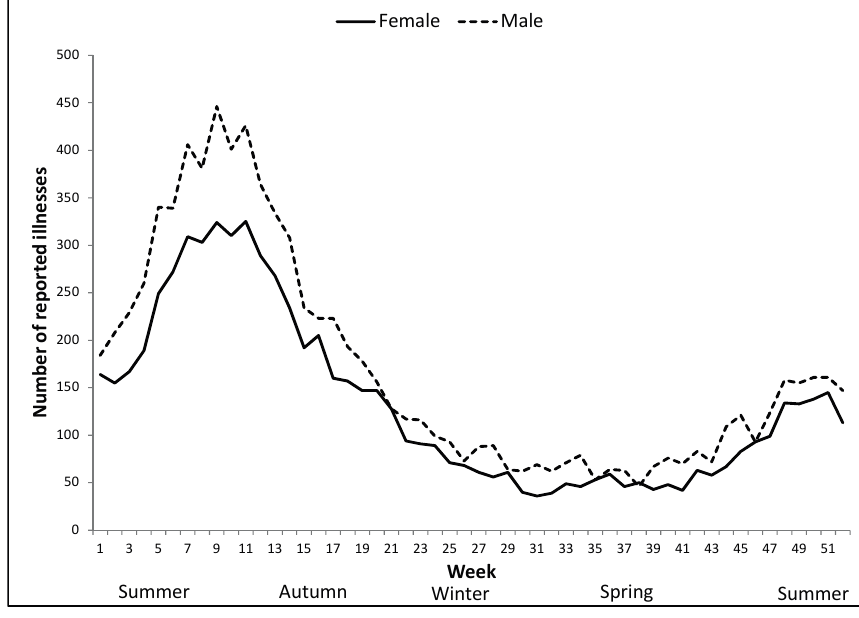
Figure 2. Total weekly number of reported cryptosporidiosis illnesses across Australia for male and female children <5 years,